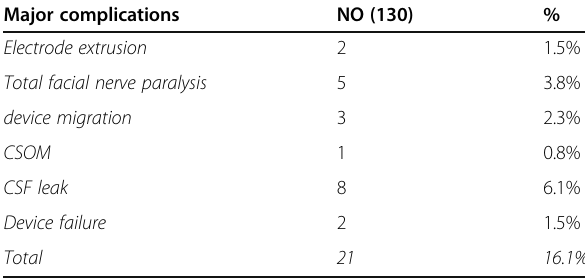
Table 2 Major complications among the studied group Major